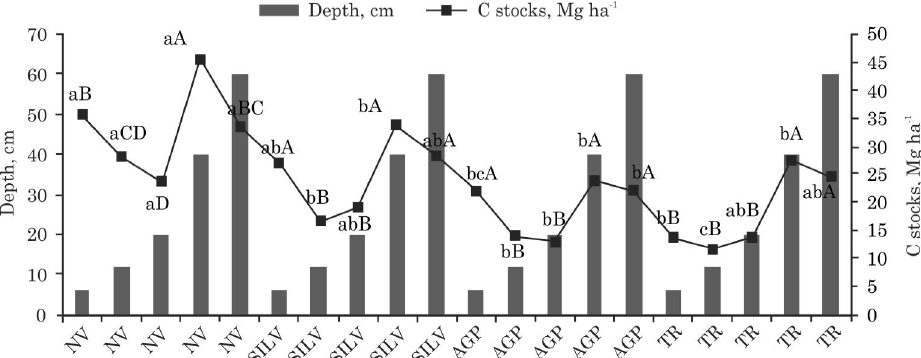
Means followed by the same letter do not differ by Tukey’s test at 5 %; uppercase letters compare the landforms and lowercase letters the management